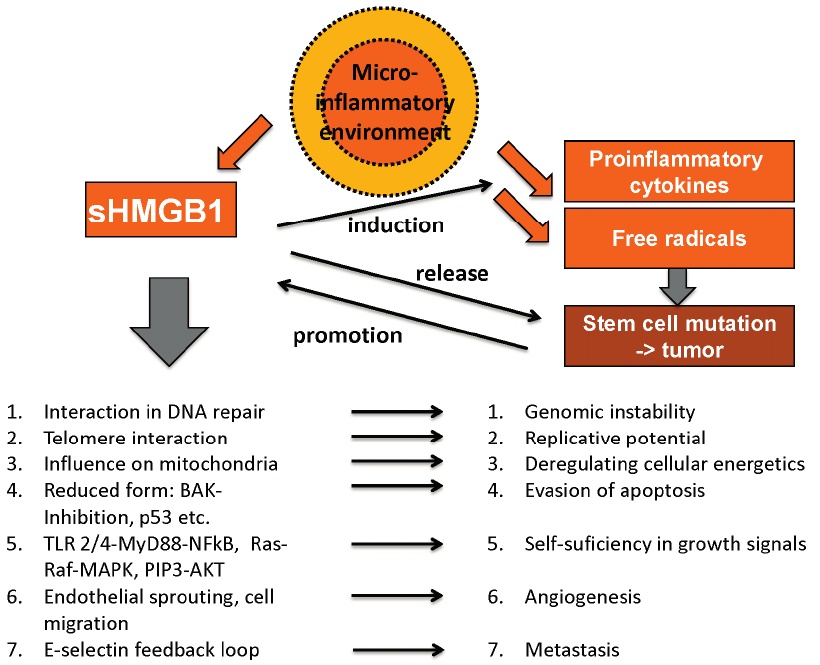
Figure 4. Tumor-promoting abilities of HMGB1 (adapted from [103] with permission from De